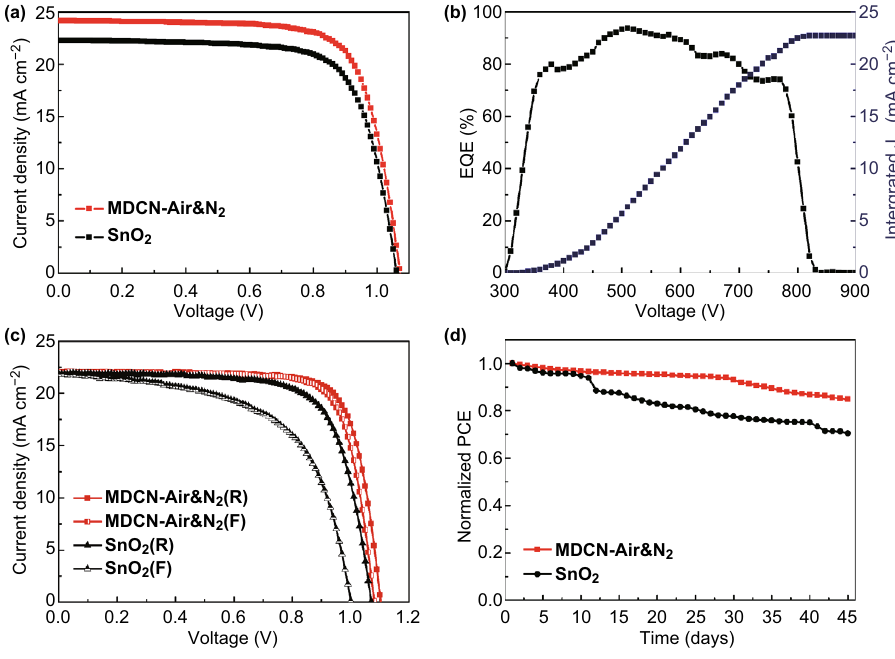
Fig. 9 a J − V curves of champion PSCs with MDCN‑Air&N 2 and SnO 2 ETL. b EQE spectrum and corresponding integrated J SC of PSC with MDCN‑Air&N 2 ETL. c Hysteresis J − V curves and d PCE stability of PSCs with MDCN‑Air&N 2 and SnO 2 ETL